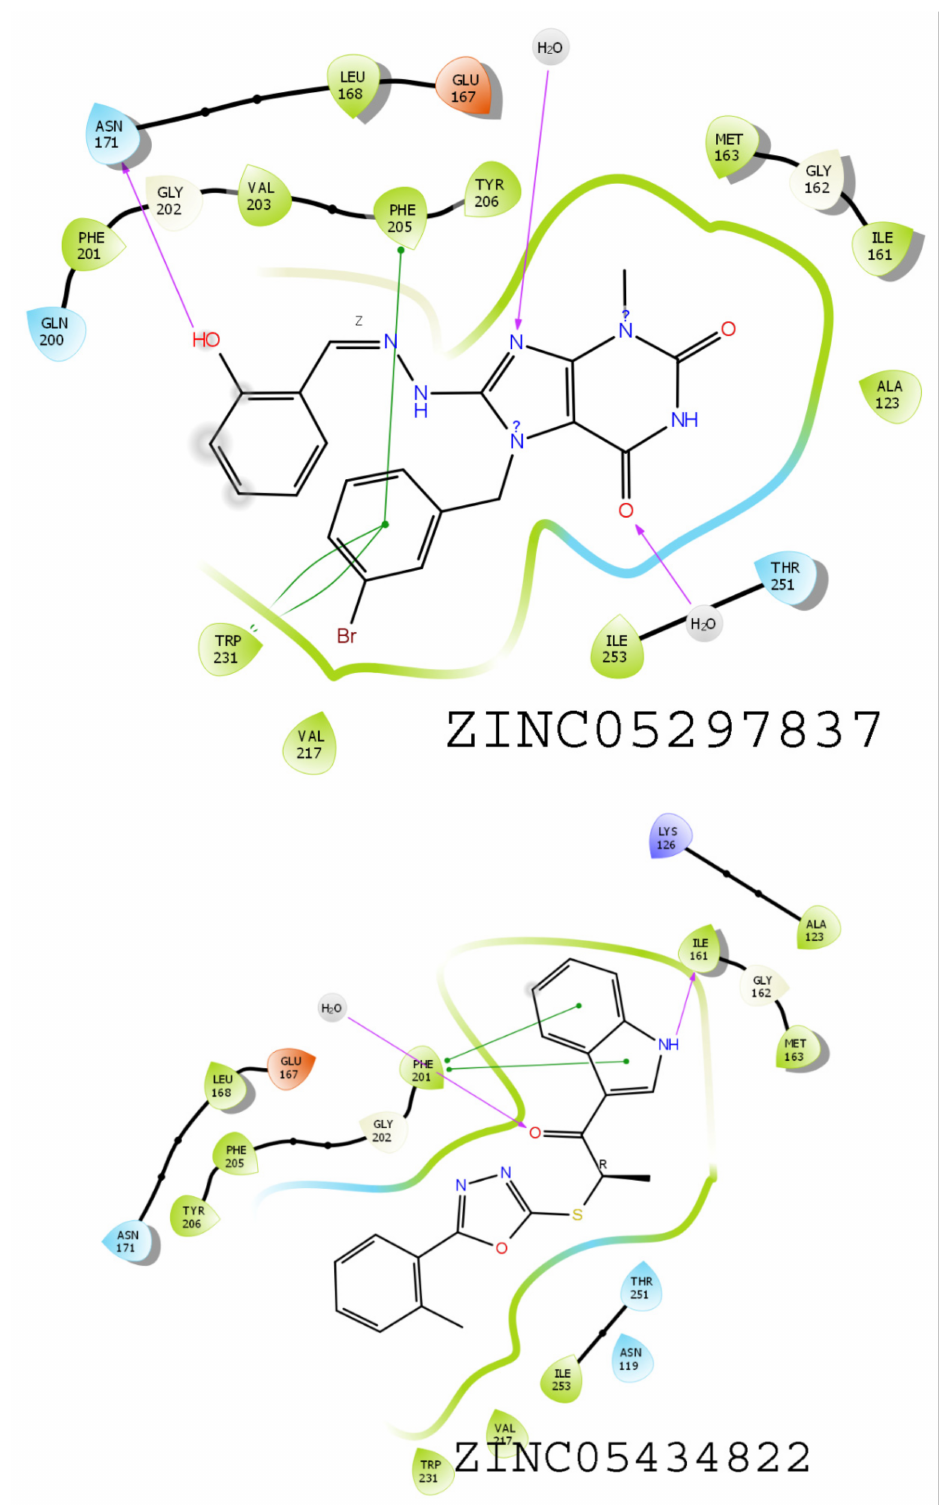
Figure 9. TRAP1(PDB ID:5Y3N) with ZINC05297837 and ZINC05434822 compounds showing binding interactions with amino